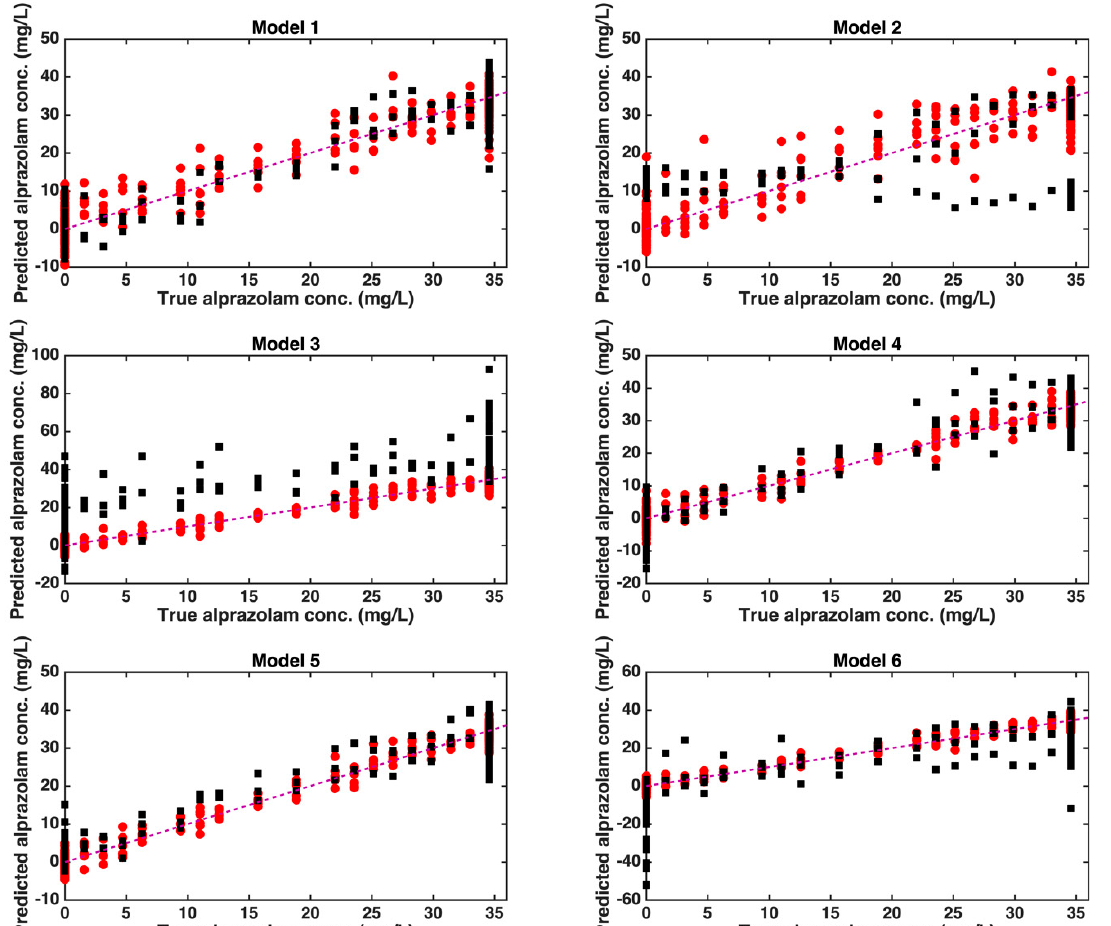
Figure 3. Results of PLS calibration for the quantification of alprazolam in spiked drinks. Plots of predicted vs. true values for the six calculated models. Legend: red circles, training samples; black squares, test samples.